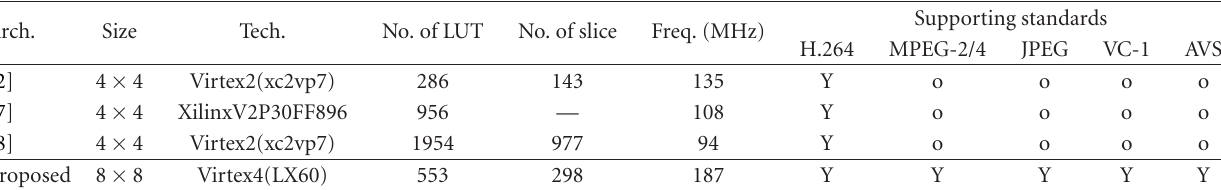
Table 3: Comparison with the existing designs (quantization